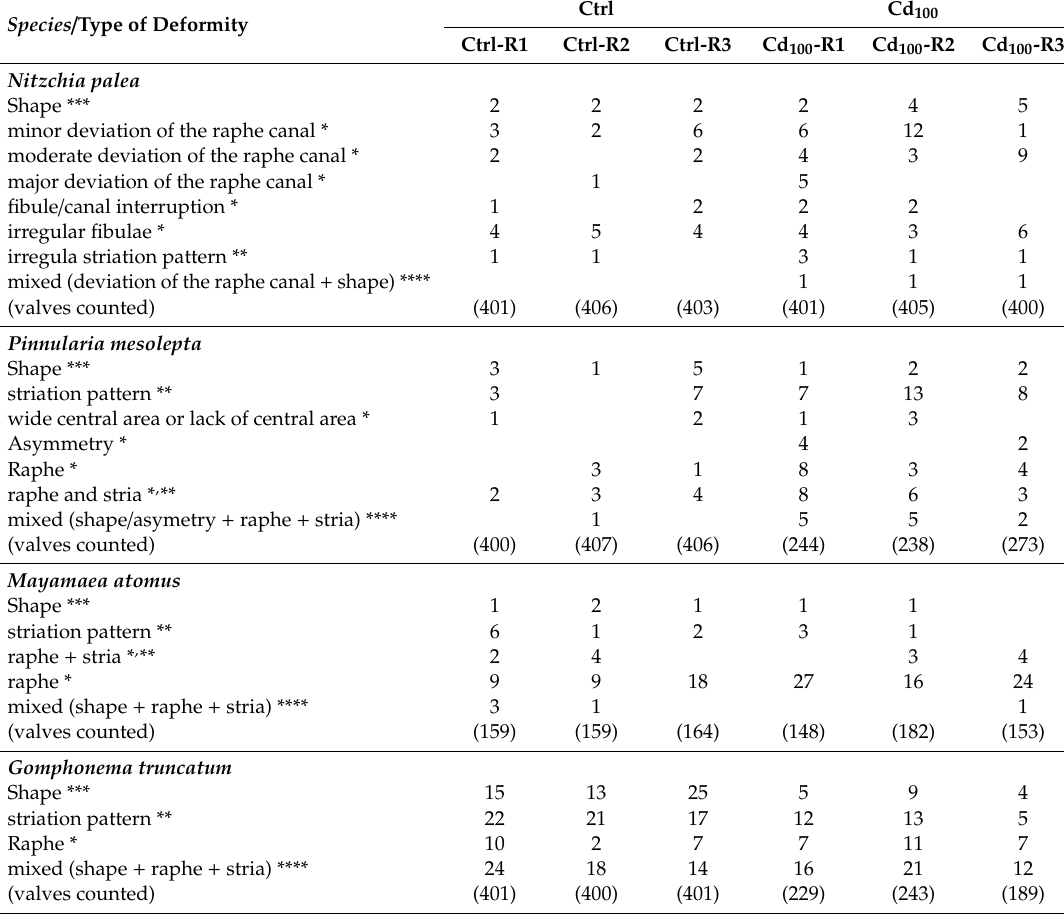
Table 3. Deformities observed on the four diatom species ( N. palea, P. mesolepta, M. atomus , and G. truncatum ) after 21 days of the experiment for the control (Ctrl) and the Cd treatment (Cd 100 ). Microscopic observations were conducted on triplicate samples (labeled R1 to R3). The number of valves counted for each sample is indicated between brackets. Early-morphogenesis *, mid-morphogenesis **, late-morphogeneis ***, mixed